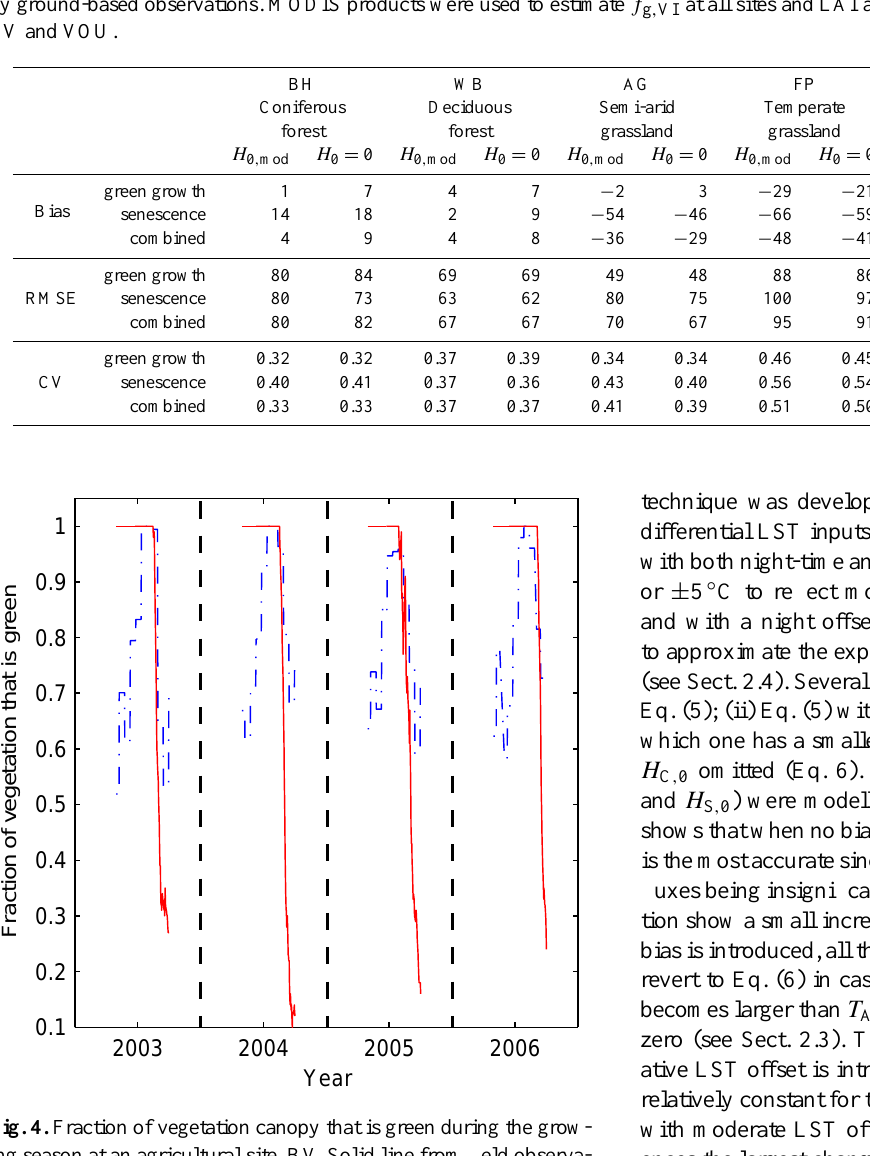
Fig. 5. Instantaneous modelled sensible heat flux during green growing season (crosses) and senescence (cir- cles) with DTD driven by field measured LST with t 0 at one hour past sunrise at the agricultural site (BV) with f g = 1 (a) , f g adjusted based on VI (b) and f g from field observations of LAI (c) . Senescence at BV starts between day of year 216 and 249.